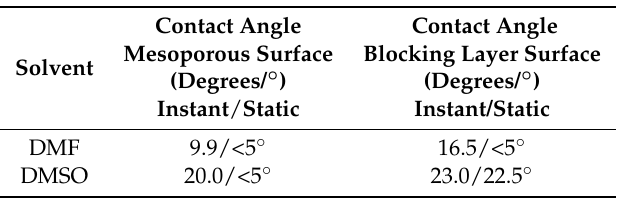
Table 1. Static contact angles measured on mesoporous titanium dioxide or compact blocking layer of lead iodide inks.